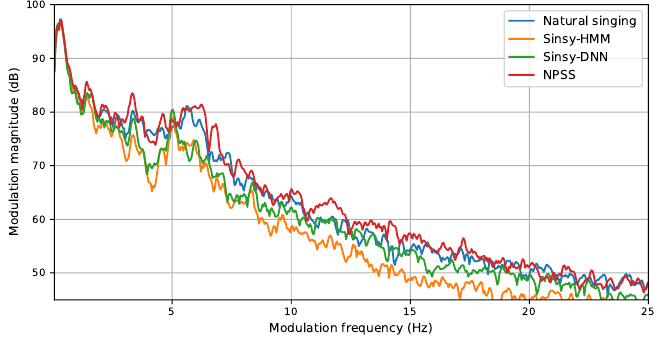
Figure 6. Comparing the average modulation spectrum of log F0 contours predicted by various systems and natural